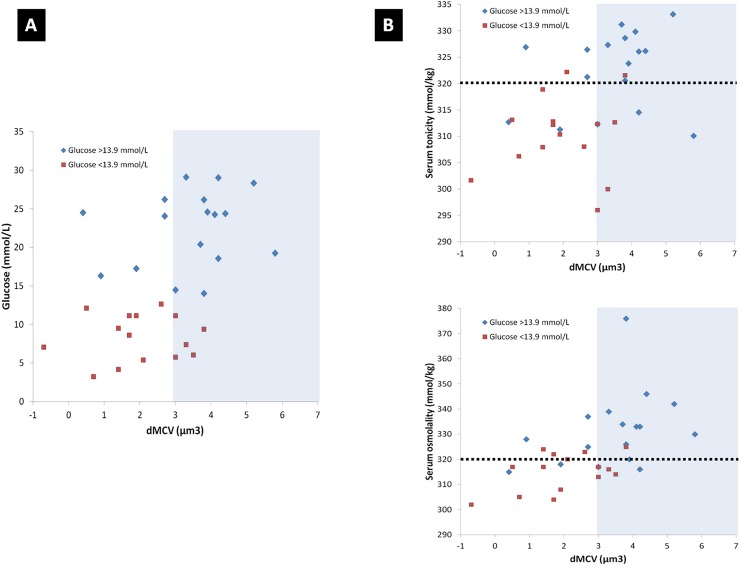
Relationships between dMCV and glucose, ST, and OsMT.Panel A–The relationship between the dMCV and serum glucose in dogs with serum glucose concentration ≥ 13.9 mmol/L (blue diamonds) or < 13.9 mmol/L (red squares) is shown. The blue shaded area indicates dMCV values above the 3 μm3 cut-off used to classify dogs with serum hypertonicity. Panel B–Relationships between dMCV and ST (top) and OsMT (bottom) in dogs classified as described in Panel A. The blue shaded area indicates dMCV values above the 3 μm3 cut-off used to classify dogs with serum hypertonicity. The black dotted line indicates the cut-off (320 mmol/kg) that represents clinically relevant elevations in ST and OsMT.